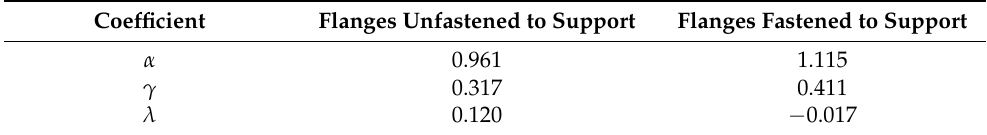
Table 8. Proposed equation coefficients for reduction factor